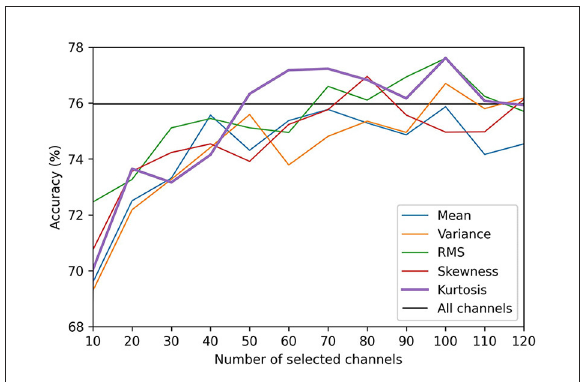
FIGURE2 Comparison of valence classification accuracies for different EEG channel selection